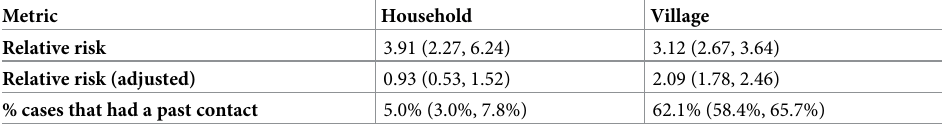
Table 3. Household and village clustering